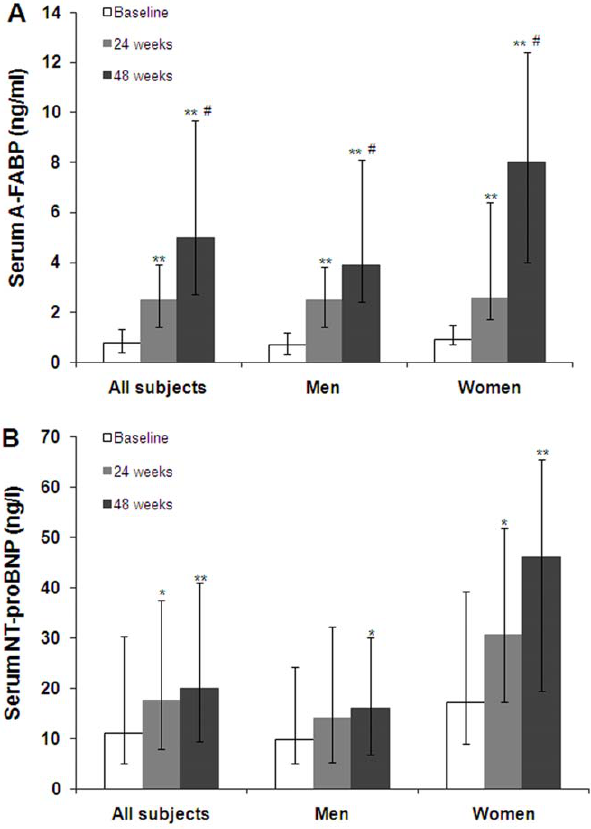
Figure 1. Serum A-FABP and NT-proBNP concentrtions at baseline and after 24 and 48 weeks of rosiglitazone therapy in 84 patients with newly diagnosed T2DM. Data are median with interquartile range. A: Serum A-FABP levels at baseline and after 24 and 48 weeks of rosiglitazone therapy were 0.8 (0.4–1.3) ng/ml, 2.5 (1.4–3.9) ng/ml, and 5.0 (2.7–9.7) ng/ml for all patients, 0.7 (0.3–1.2) ng/ml, 2.5 (1.4–3.8) ng/ml, and 3.9 (2.4–8.1) ng/ml for men, and 0.9 (0.7–1.5) ng/ml, 2.6 (1.7–6.4) ng/ml, and 8.0 (4.0–12.4) ng/ml for women. B: Serum